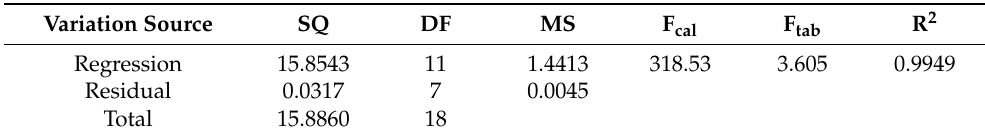
Table 5. ANOVA and coefficient of determination of the factorial design of acid-functionalized sample with the variable (Q t ).